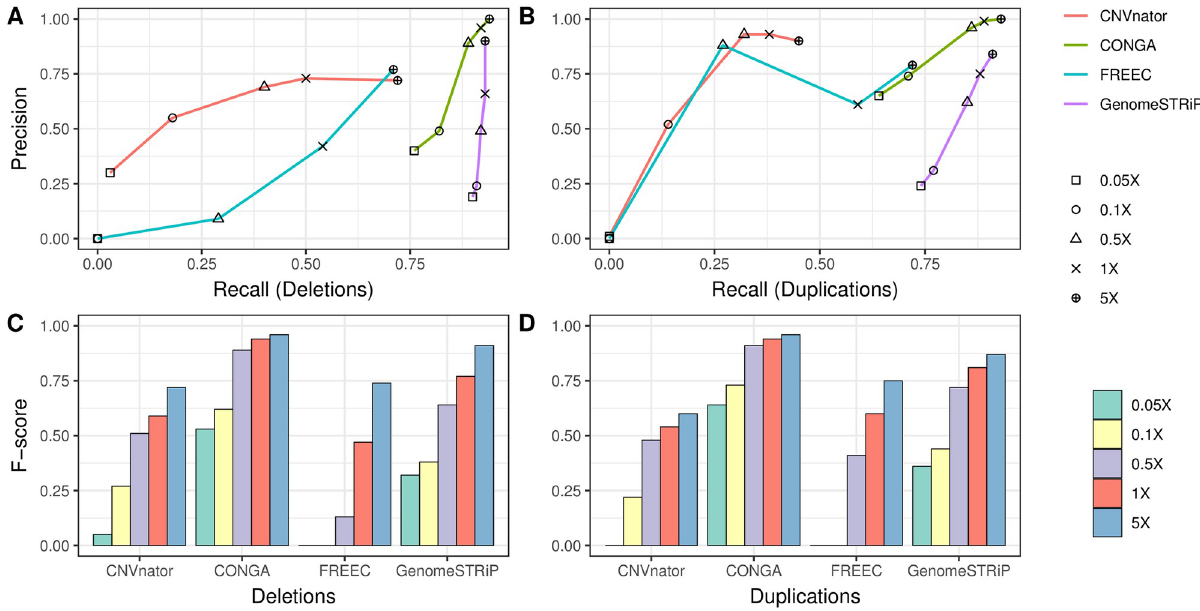
Fig 2. CNV prediction performances of CONGA, GenomeSTRiP, FREEC and CNVnator on simulated genomes. In (A) and (B), we show recall- precision curves based on depths of coverage values for deletions and duplications, respectively. In (C) and (D), we show the F-scores, calculated as (2 × Precision × Recall )/( Precision + Recall )). The figures represent the average statistics calculated for medium (1 kbps–10 kbps) and large (10 kbps–100 kbps) CNVs. See Table A in S1 Table for detailed information including small (100 bps–1 kbps) CNVs, as well as mrCaNaVaR predictions for large variations. Commands used to run each tool are provided in S1 Text. The results here were generated using the cutoff C-Score < 0.5 for CONGA, while no read-pair or mappability filters were applied.